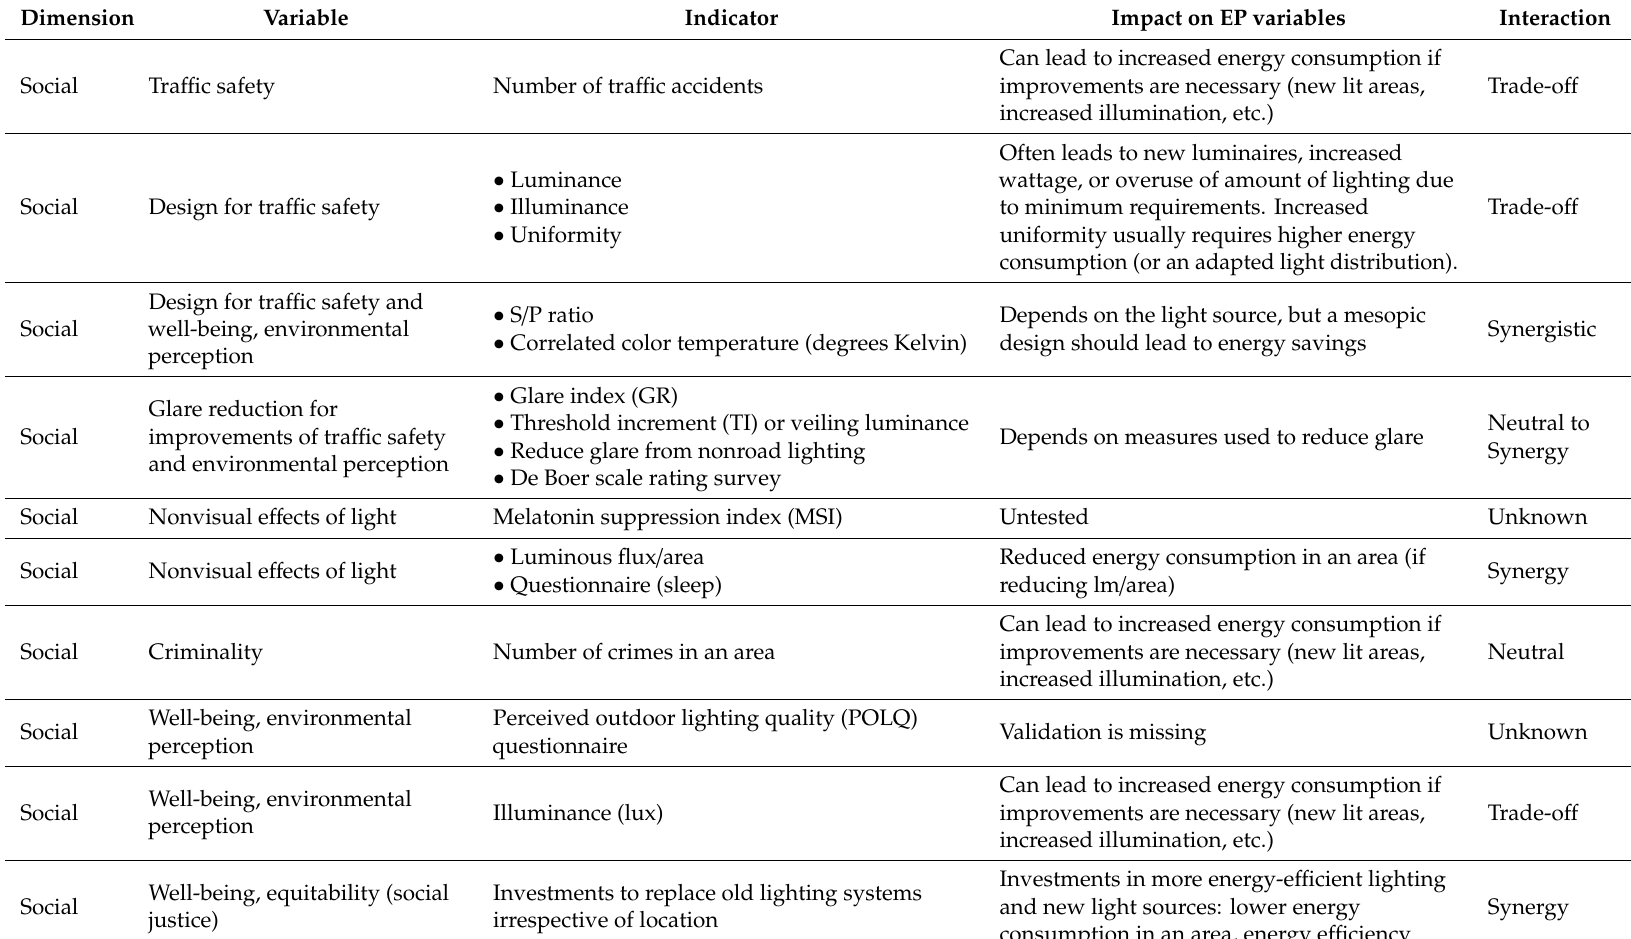
Table 5. Dimension, impact and interaction between the sustainability indicators in the social dimension and energy performance (EP)